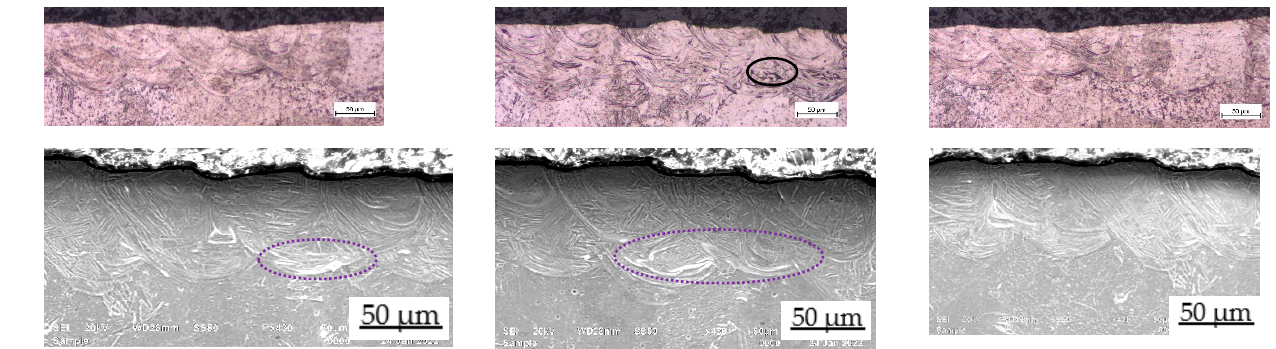
Figure 9. Optical and secondary electron images of the Ti5Mo cross-sectional view.